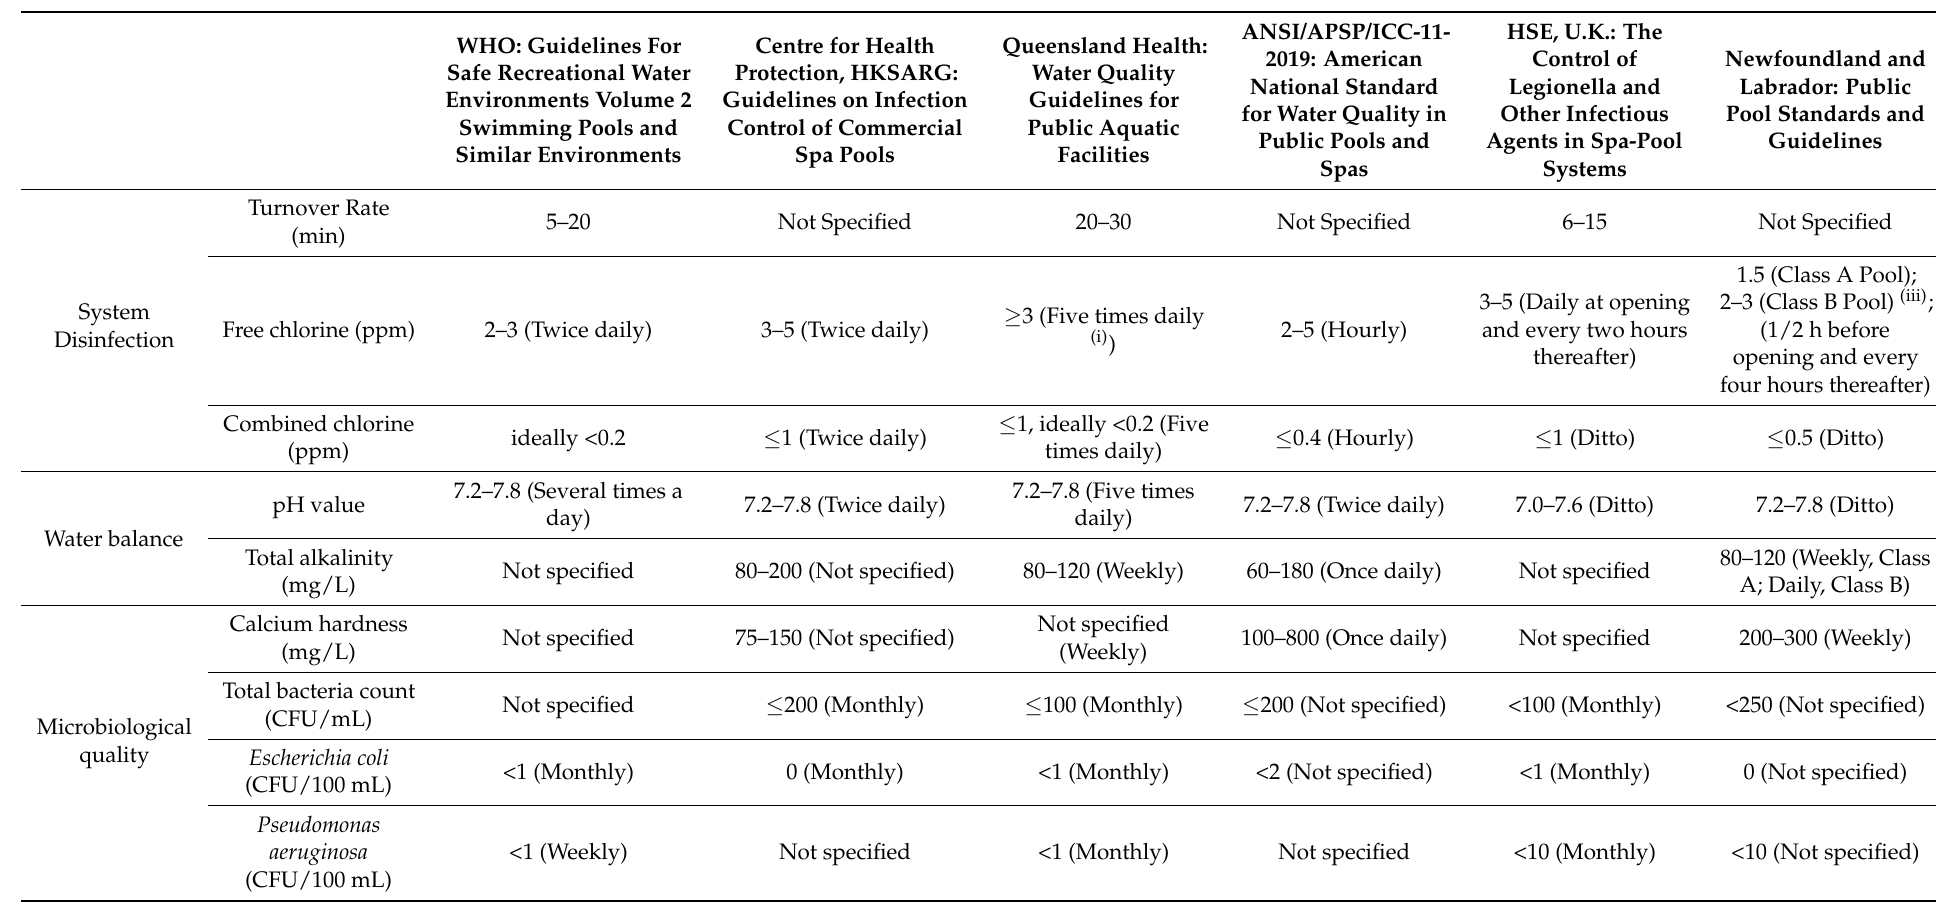
Table 1. Water quality specifications for spa